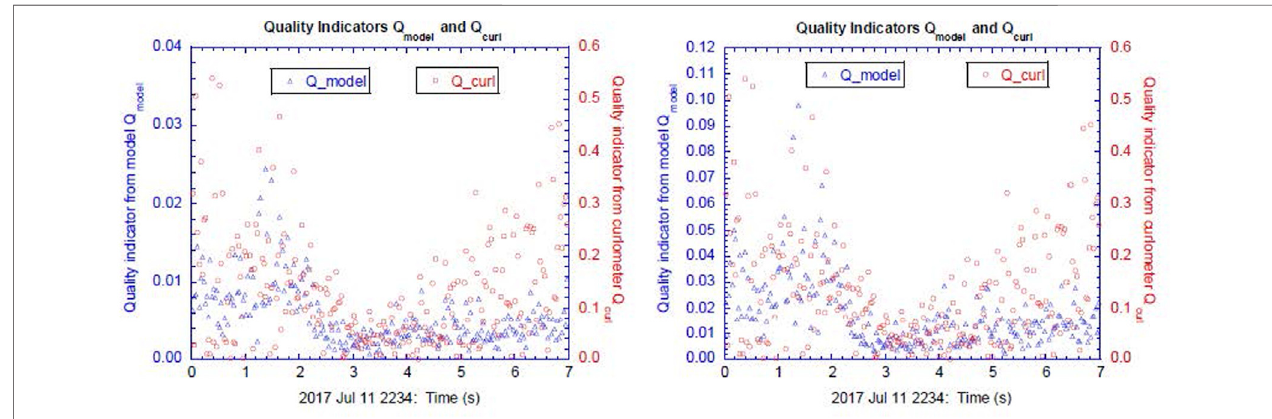
FIGURE 5 | Quality indicators Q model and Q curl representing the ratio of the divergence to the vorticity of the magnetic fi eld based on the reconstructed B fi eld and the measured ^ B fi eld by curlometer technique, respectively. The left and right panels correspond to two cases of a standard setting of σ in Eq. 8 with σ (cid:1) 0 . 1 (cid:2) σ B and an alternative setting of σ (cid:1) (cid:2) σ B ,